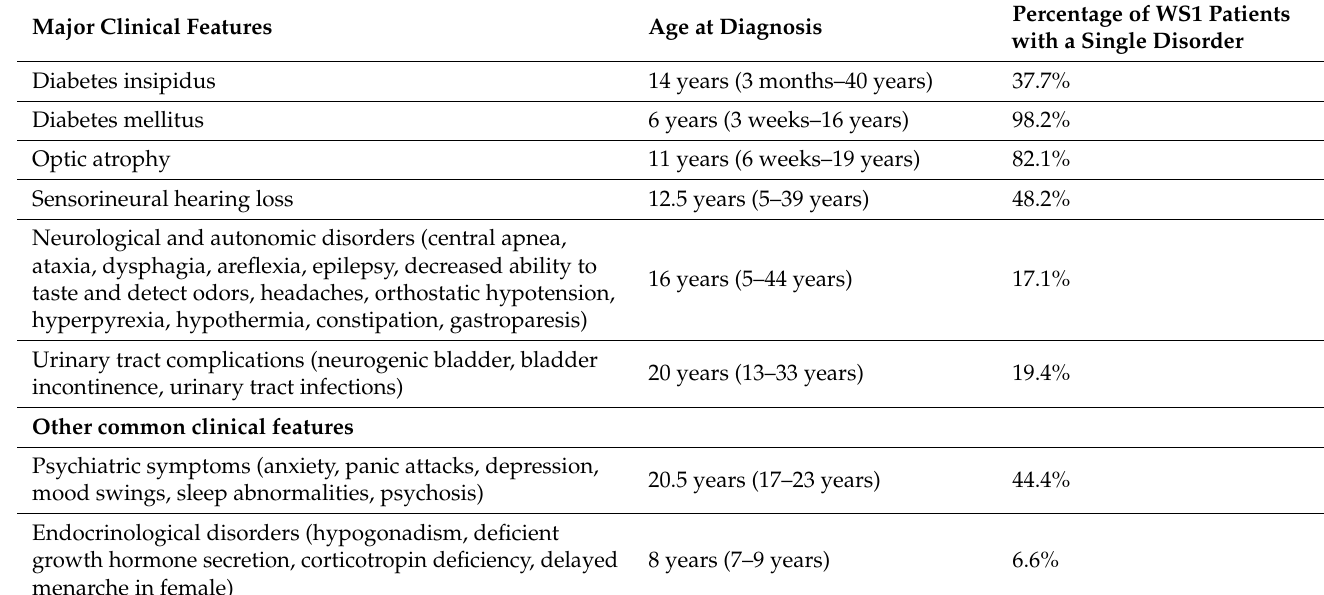
Table 2. Clinical features of patients with Wolfram syndrome